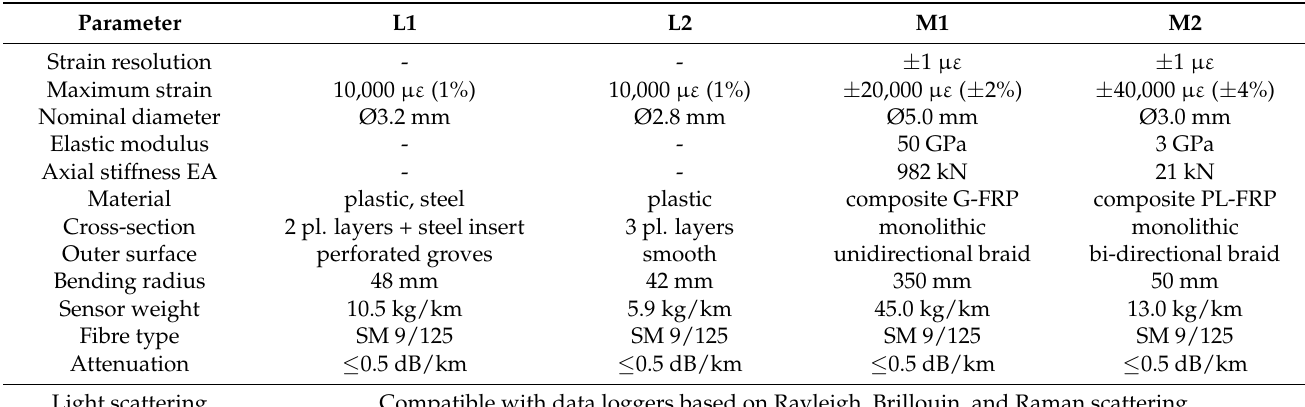
Table 2. Comparison between the parameters of selected DFOS tools.